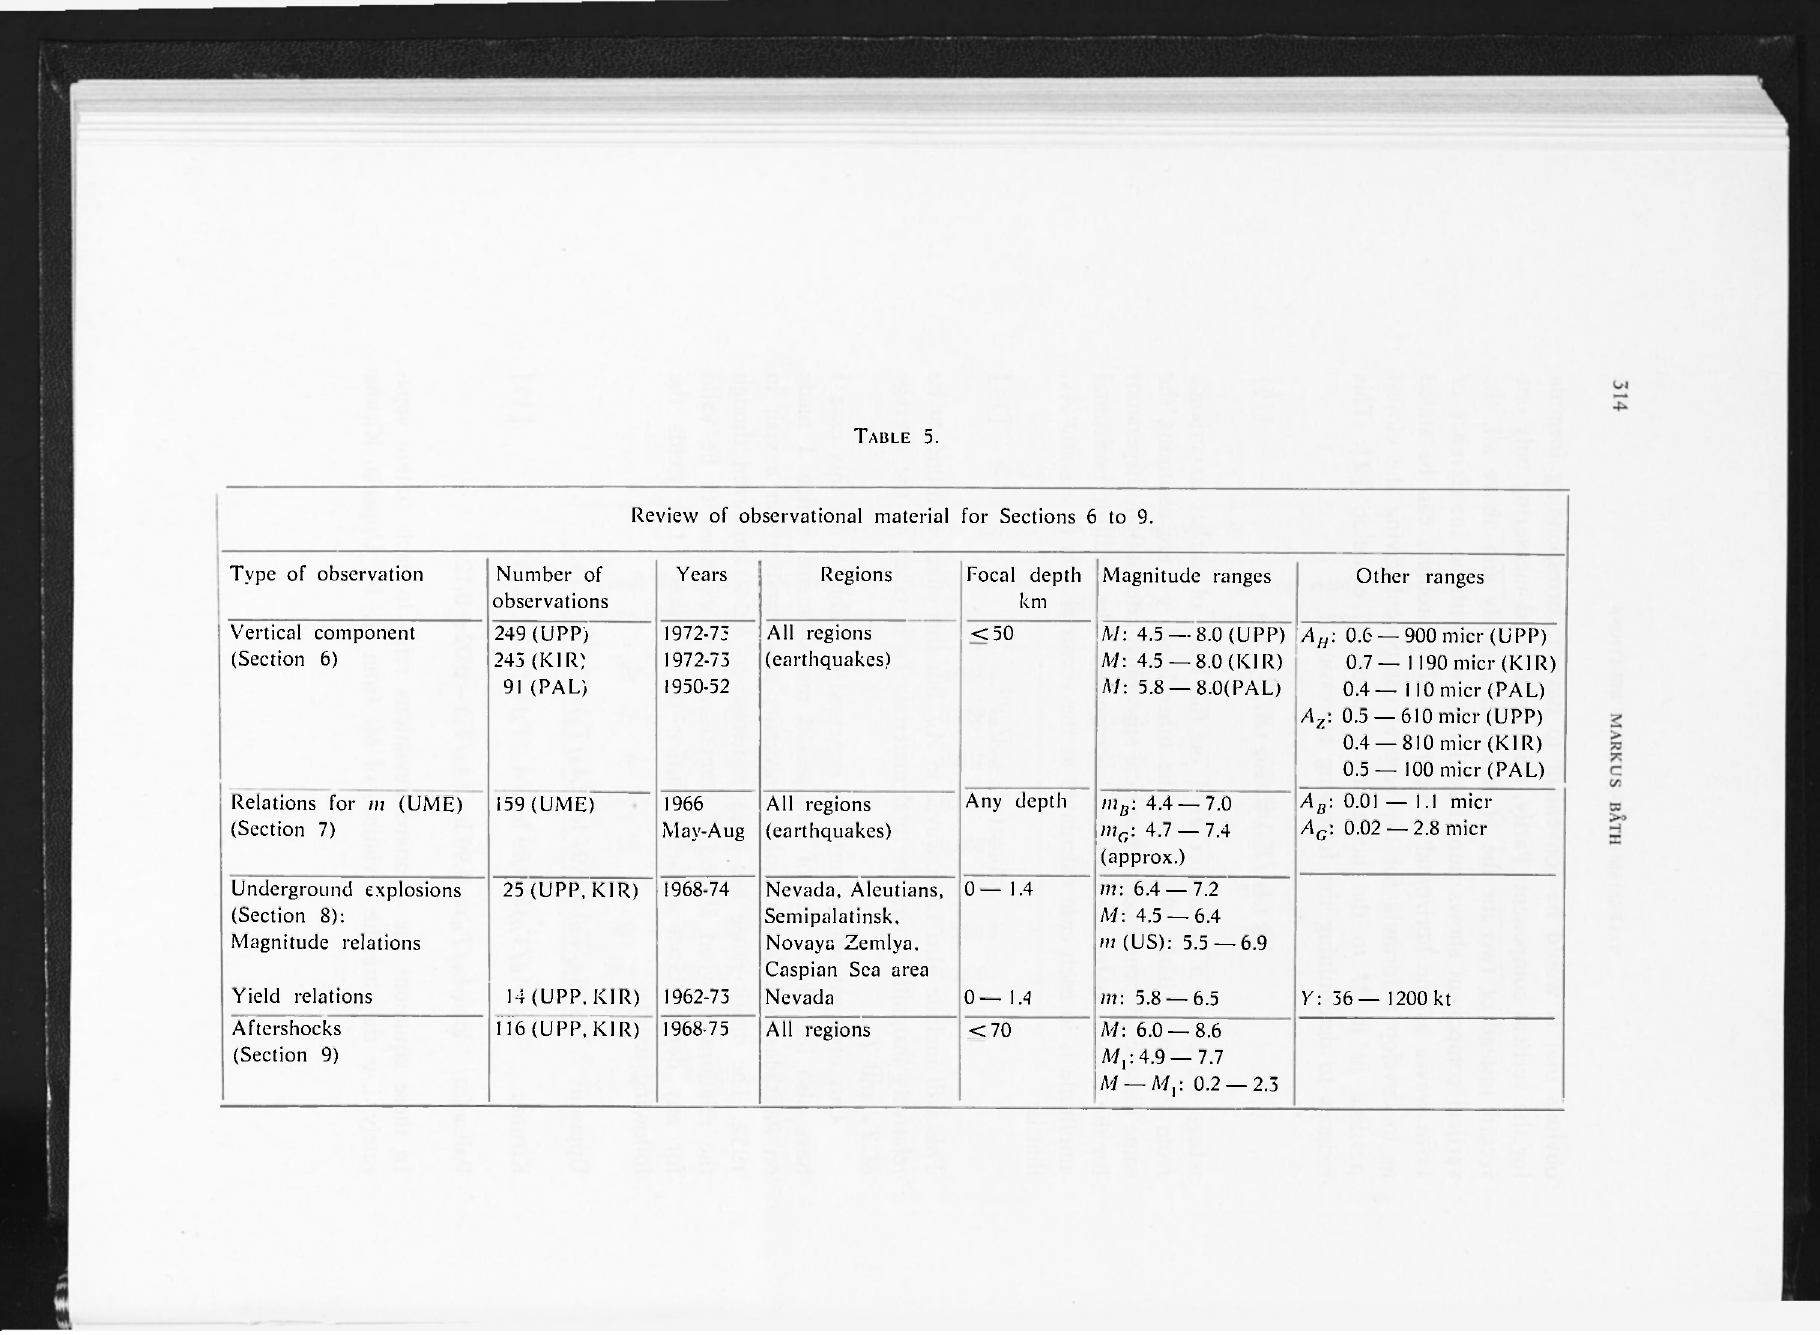
Review of observational material for Sections 6 to